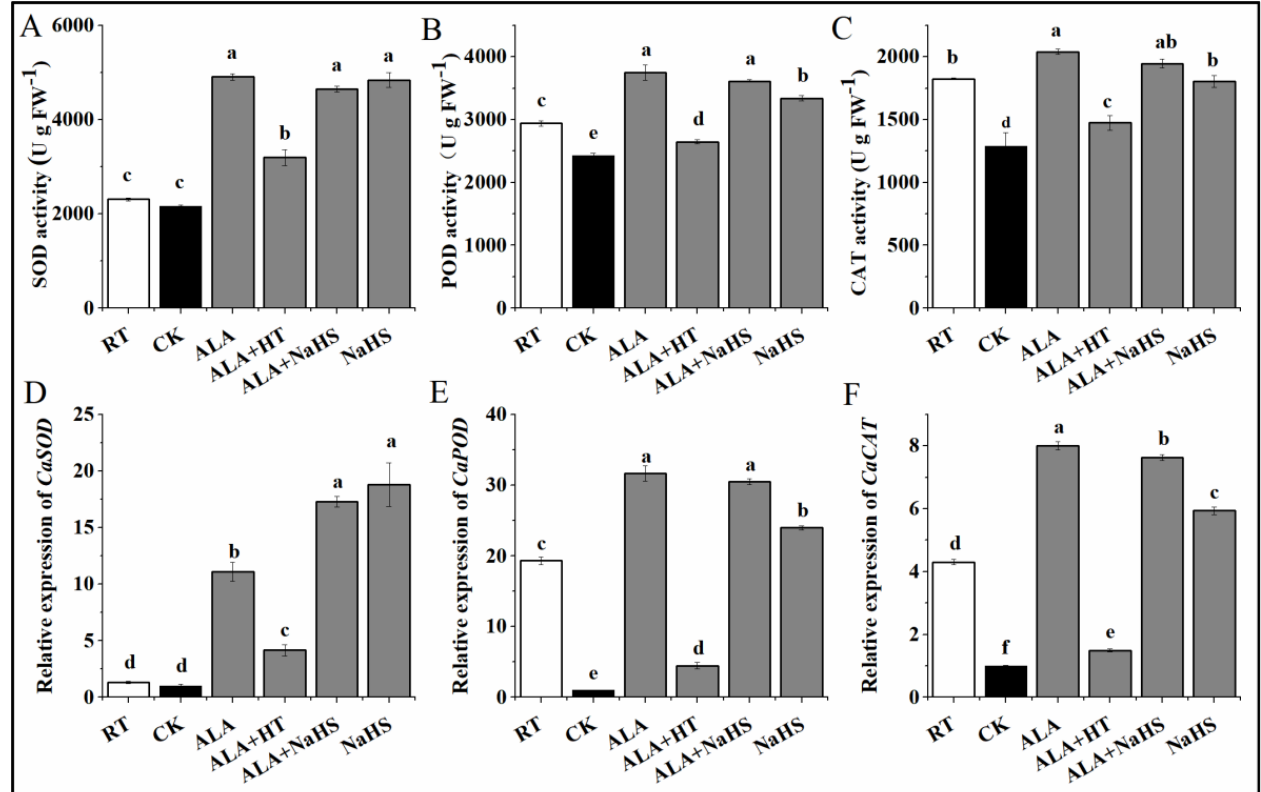
Figure 3. Effects of ALA and/or H 2 S on SOD ( A ), POD ( B ), and CAT ( C ) activities and the relative expressions of CaSOD ( D ), CaPOD ( E ), and CaCAT ( F ) under chilling stress for 24 h. The error bars are the standard errors for three independent tests. Different letters show significant differences ( p < 0.05) based on Duncan’s test.